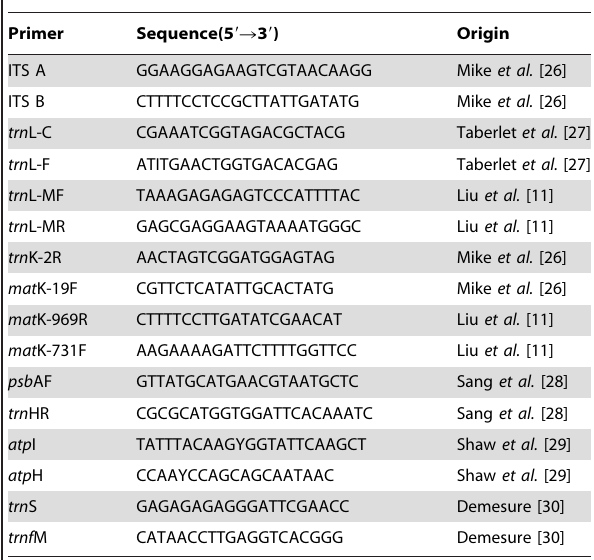
Table 3. Primers used in this